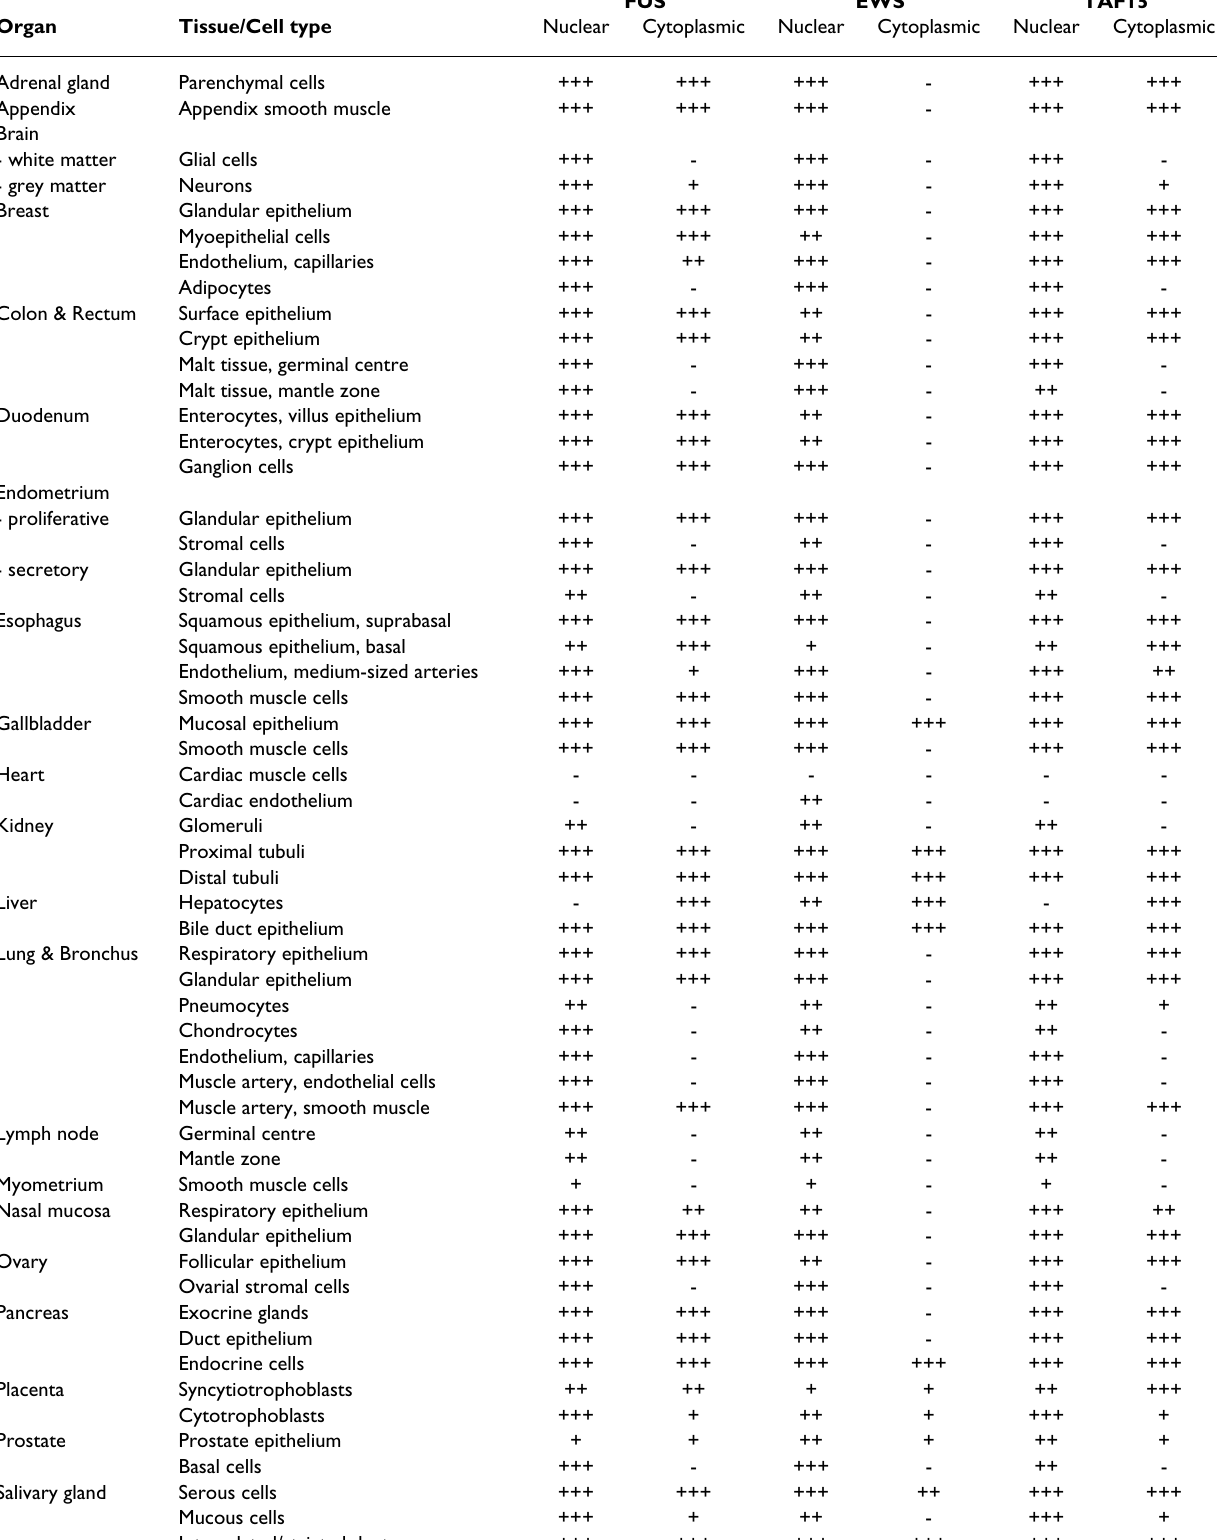
Table 1: Expression patterns of FUS, EWS and TAF15 in human tissues by TMA immunohistochemistry